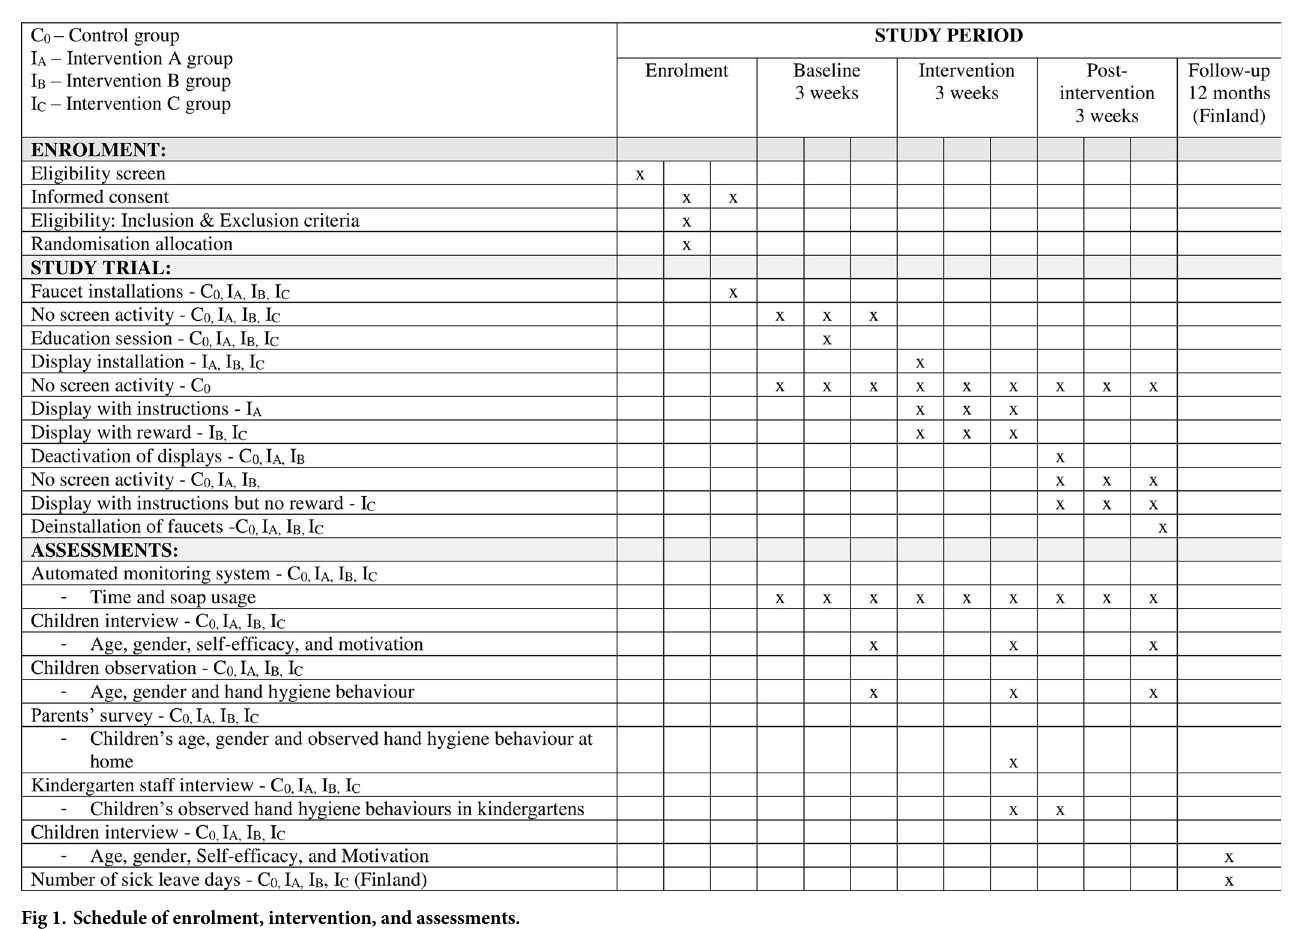
Fig 2. The design and data collection of the study.